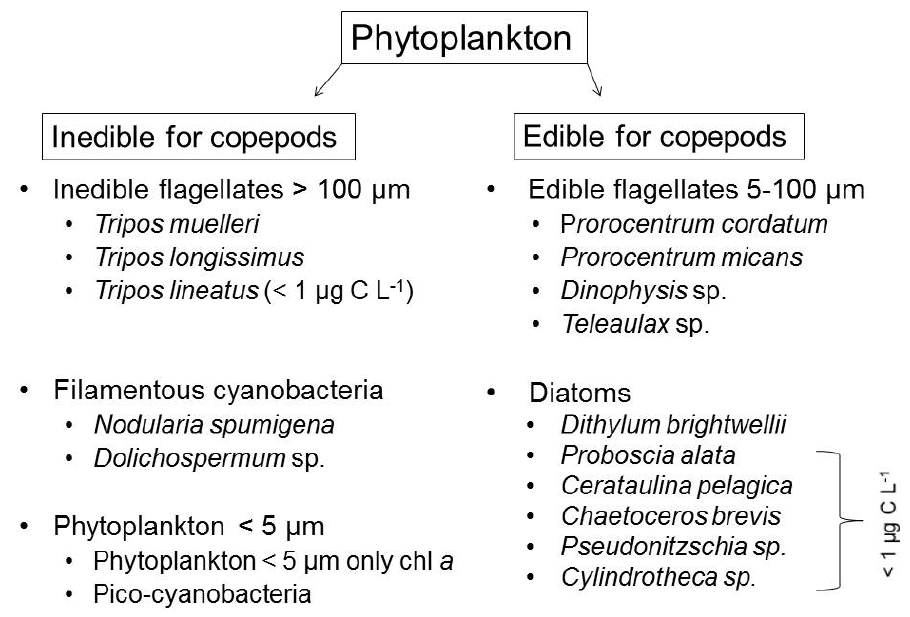
Figure 1. Overview of phytoplankton species composition. To account for feeding relationships between phytoplankton and mesozooplankton copepods, the phytoplankton was divided into two groups: inedible for copepods and edible for copepods. Species with a mean biomass <1 µ g C L − 1 were in the following not separately analyzed for species-specific treatment affects.